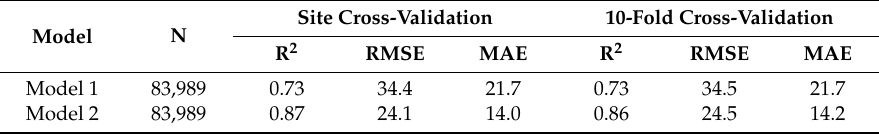
Table 6. Result comparison of model fitting and cross-validation for Model 1 and 2.